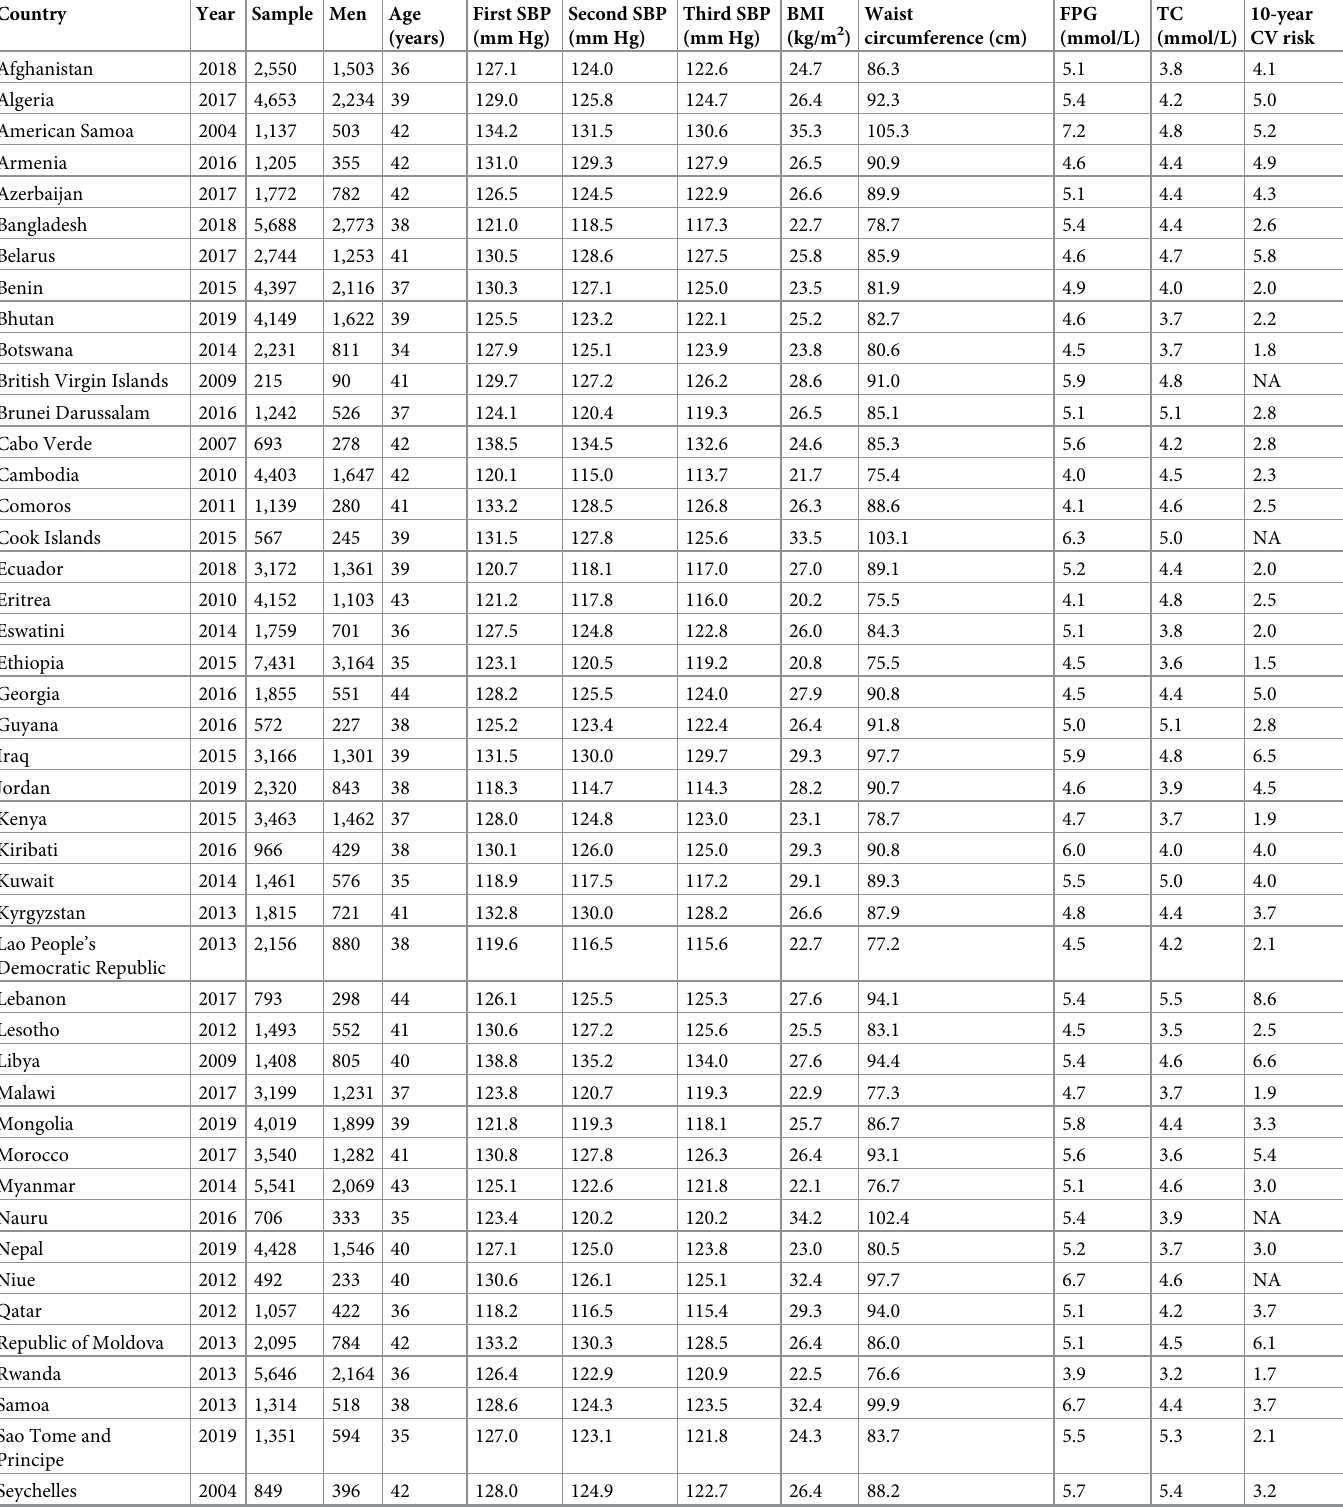
Table 1. Descriptive statistics of the analysed